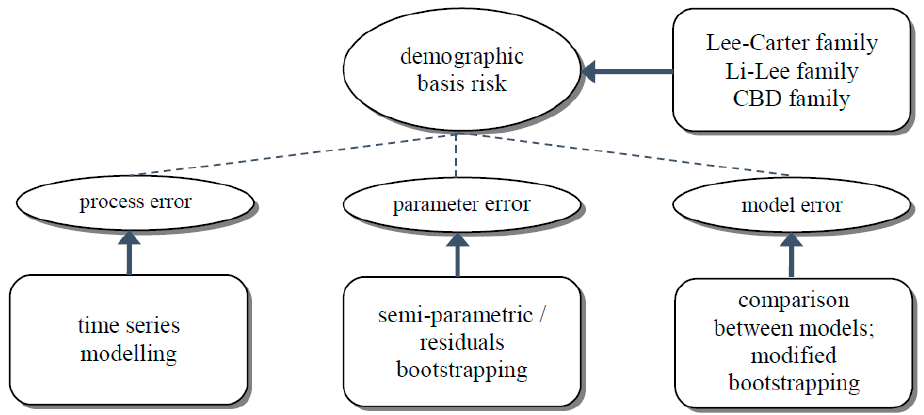
Figure 2. Allowance for process error, parameter error, and model error.